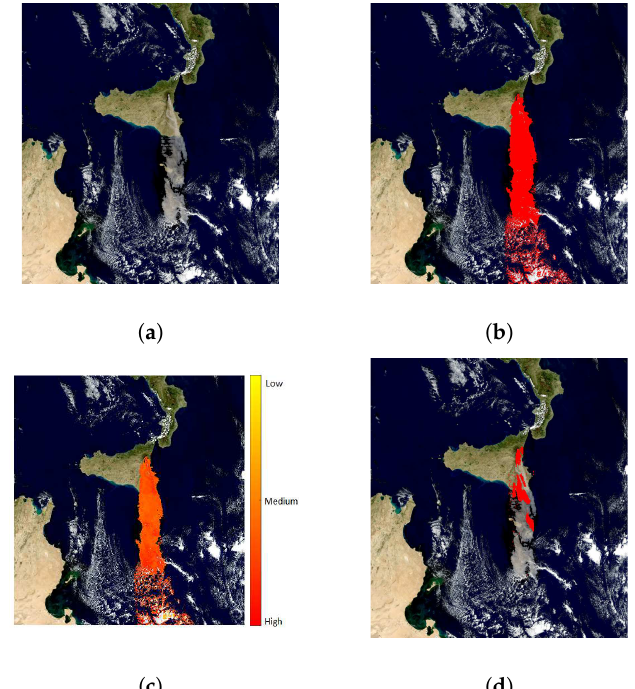
Figure 8. Result comparison from the Etna Volcano eruption, Italy, 2002. ( a ) Composed RGB MODIS image during the event. ( b ) Detection of volcanic ash based on spectral retrieval. ( c ) Ash cloud monitoring and relative concentration. ( d ) Temperature difference method.